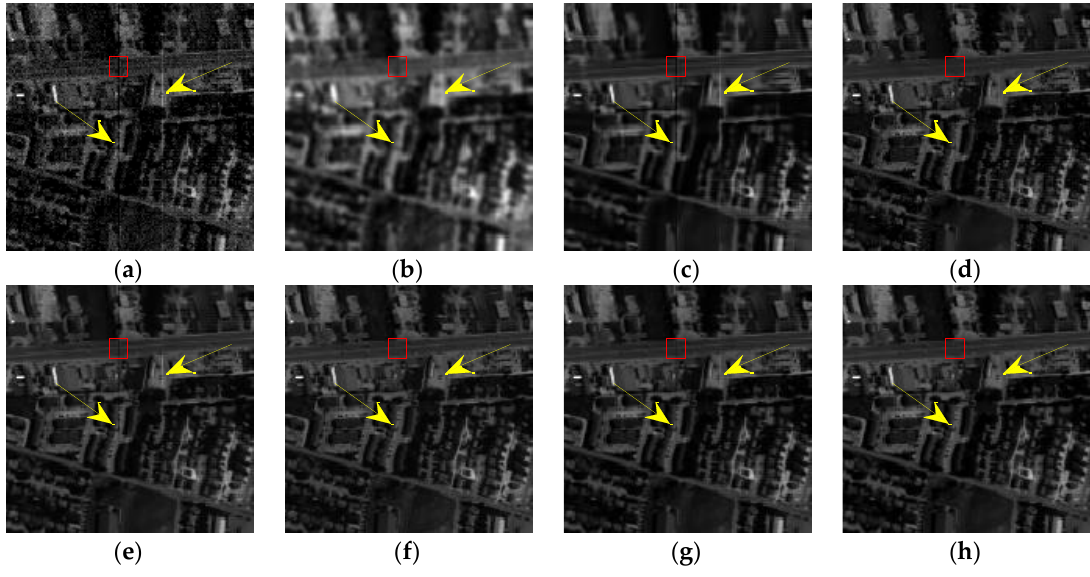
Figure 14. Restored results in Urban image: ( a ) Original band 186; ( b ) KSVD; ( c ) BM3D; ( d ) ANLM3D; ( e ) BM4D; ( f ) LRMR; ( g ) DDL3+FT; ( h ) Our